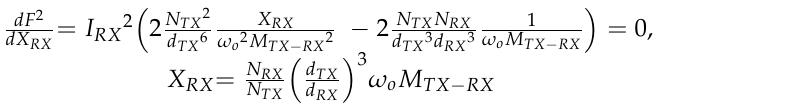
Figure 6. The vector diagram in Equation (6). The variable X RX , which becomes 0 when F 2 is differentiated with respect to X RX , is the value for minimizing the leakage magnetic field, expressed in Equation (8). As shown in Equation (8), the minimization condition of the leakage magnetic field can be determined by N TX and N RX , d TX and d RX , ω o , and the mutual inductance between the TX coil and RX coil ( M TX − RX